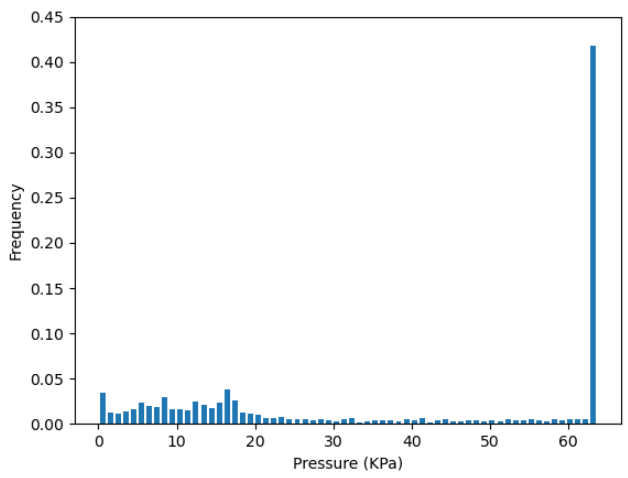
Figure 10. Pressure distribution from one-sensor Rb 2 in C r